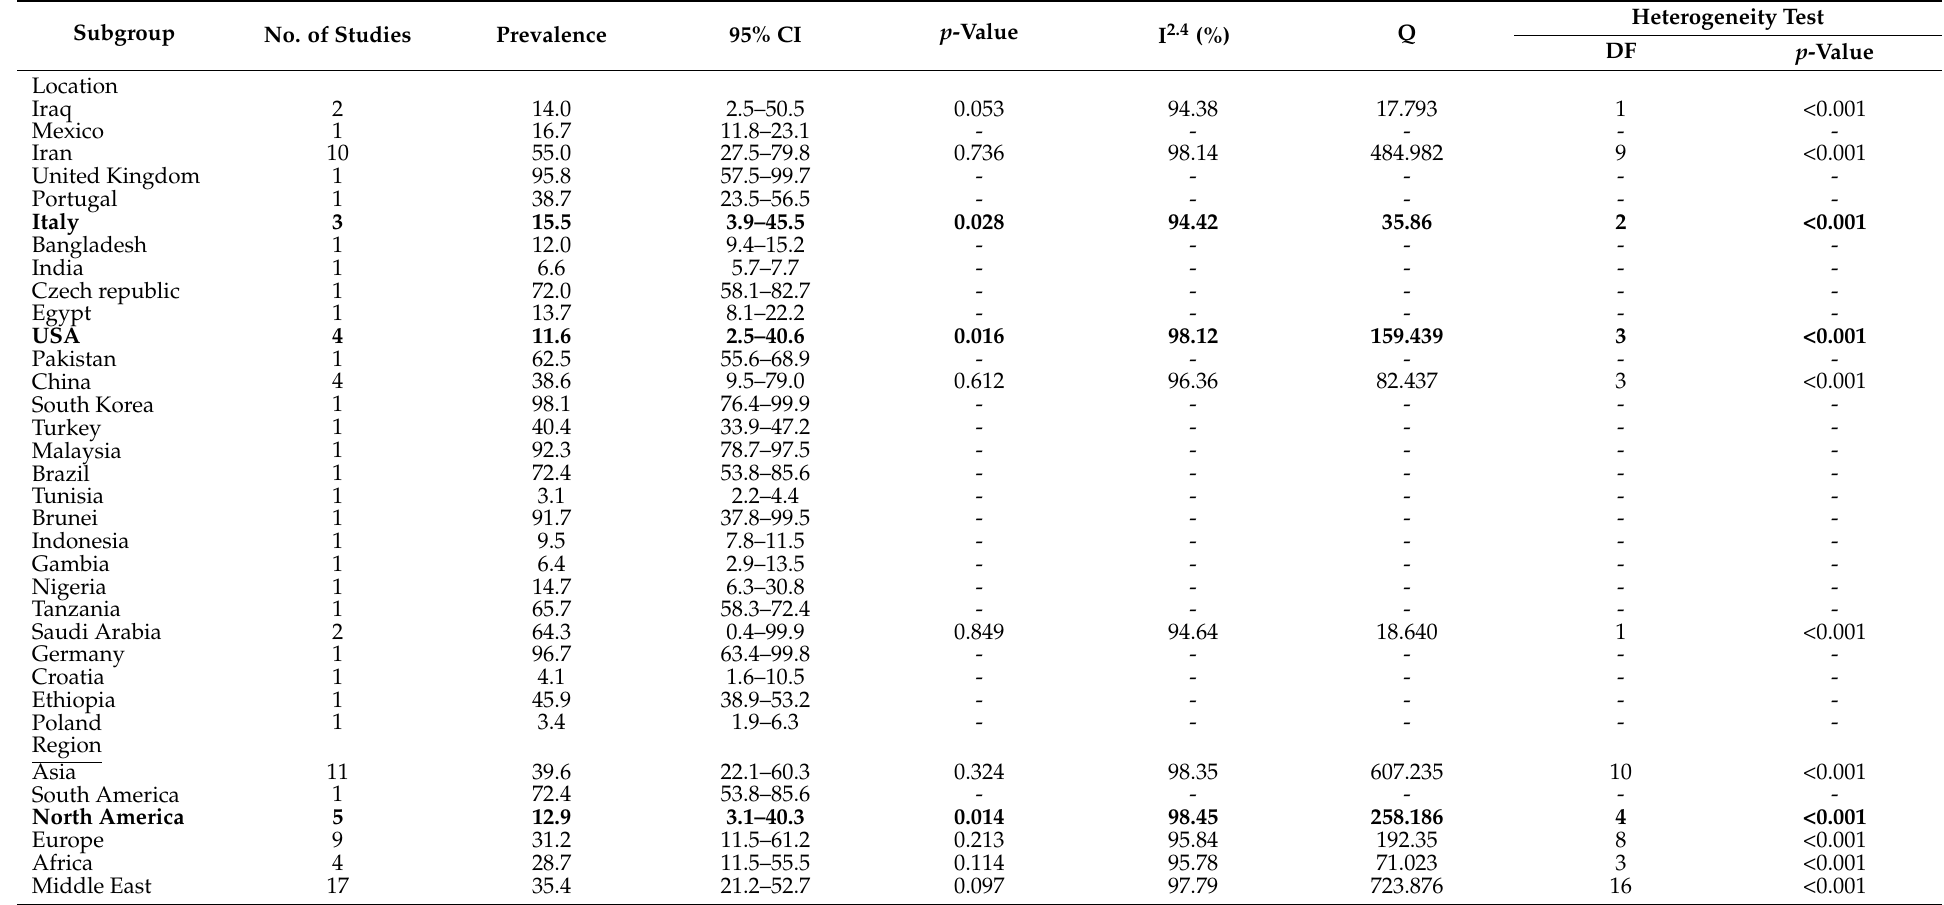
Table 2. Subgroup analysis of the prevalence of nosocomial MDR K. pneumoniae according to countries and regions.